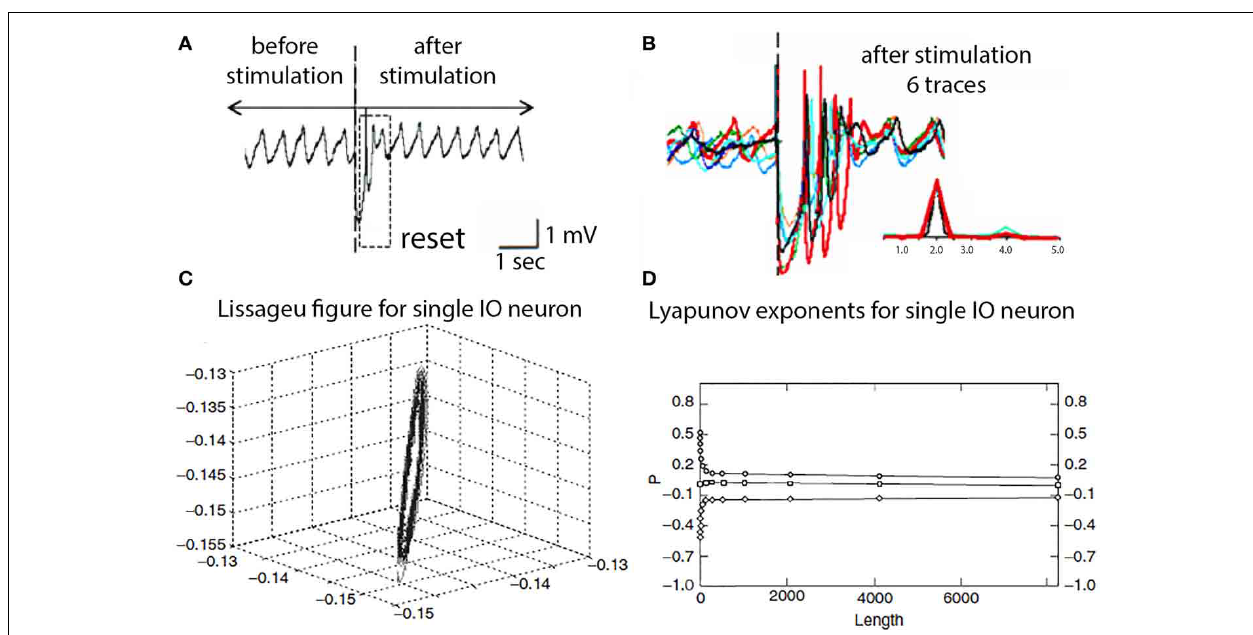
FIGURE 8 | IO oscillatory properties following spike activation. (A) One extracellular stimulusbriefly interrupted the spontaneous oscillation. (B) Superimposition ofsixtracesdemonstrating thereset oscillatoryphase is the same regardless atwhichpoint ofthe intrinsicoscillationthe stimulus was